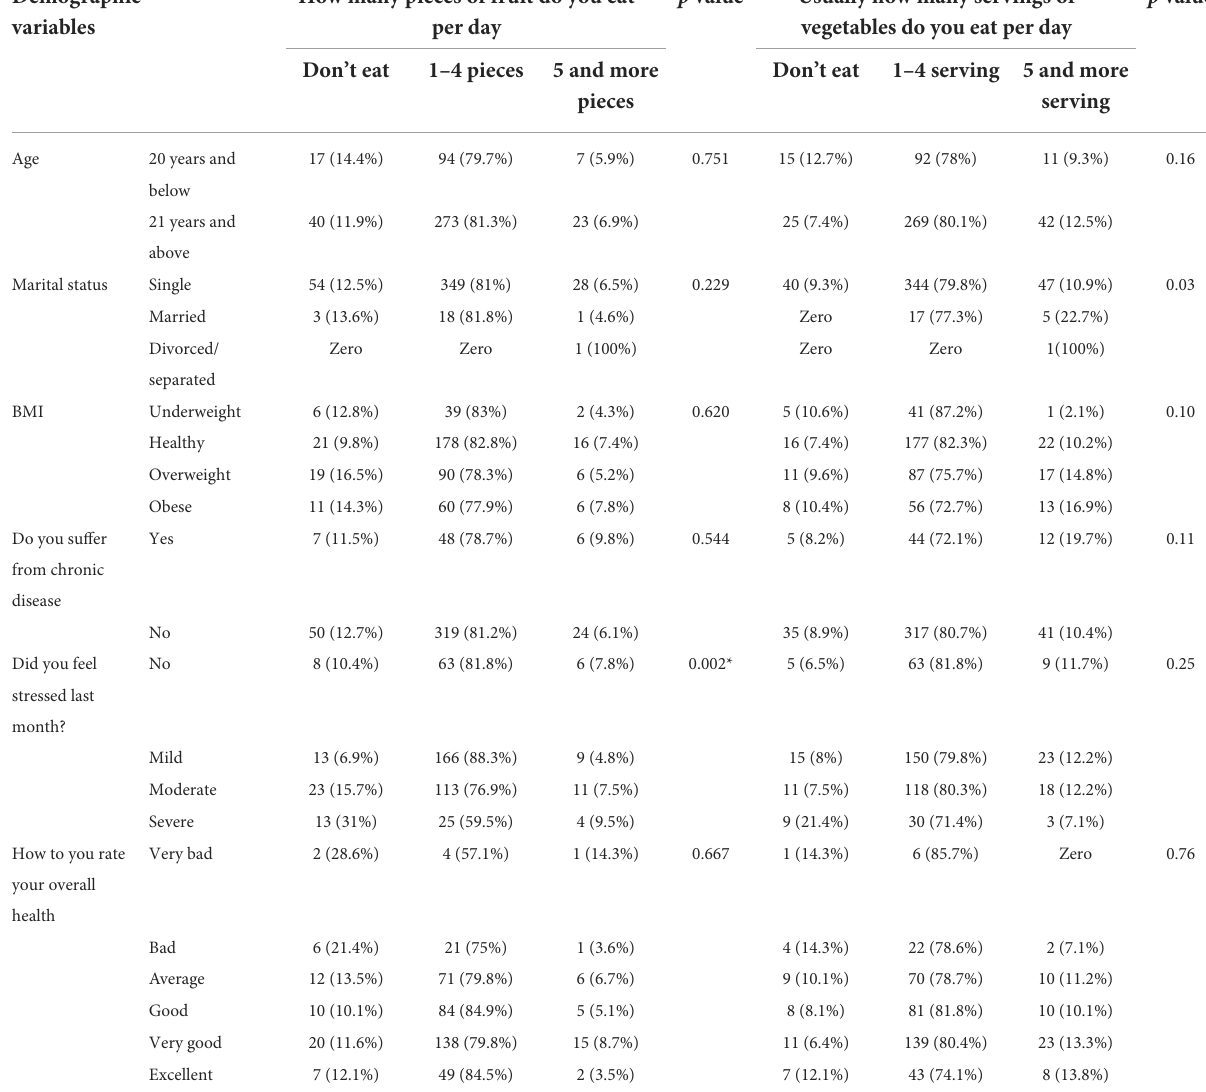
TABLE 3 Pattern of consumption of fruits and vegetables per day among male students of Najran University. Demographic